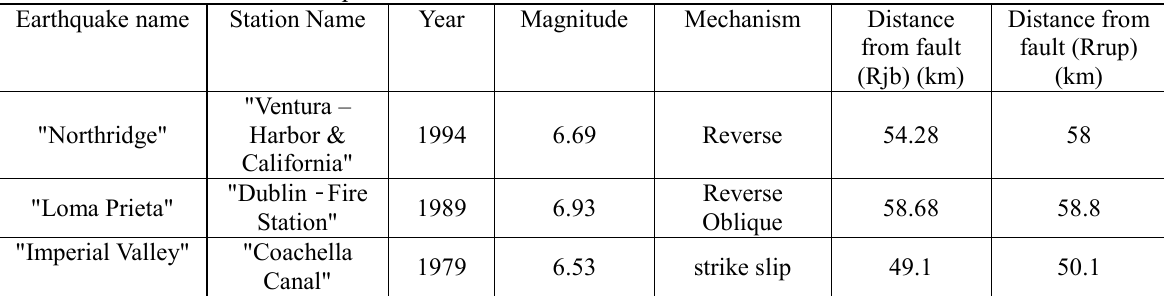
The informations of the earthquake records.